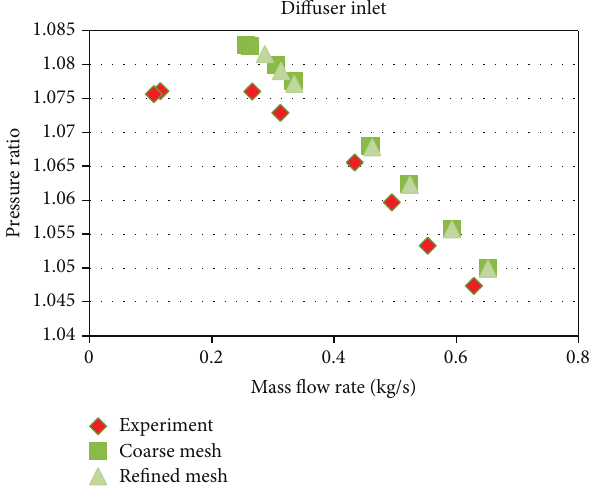
Figure 13: Pressure characteristic at the diffuser inlet for the stationary case in the diffuser inlet.